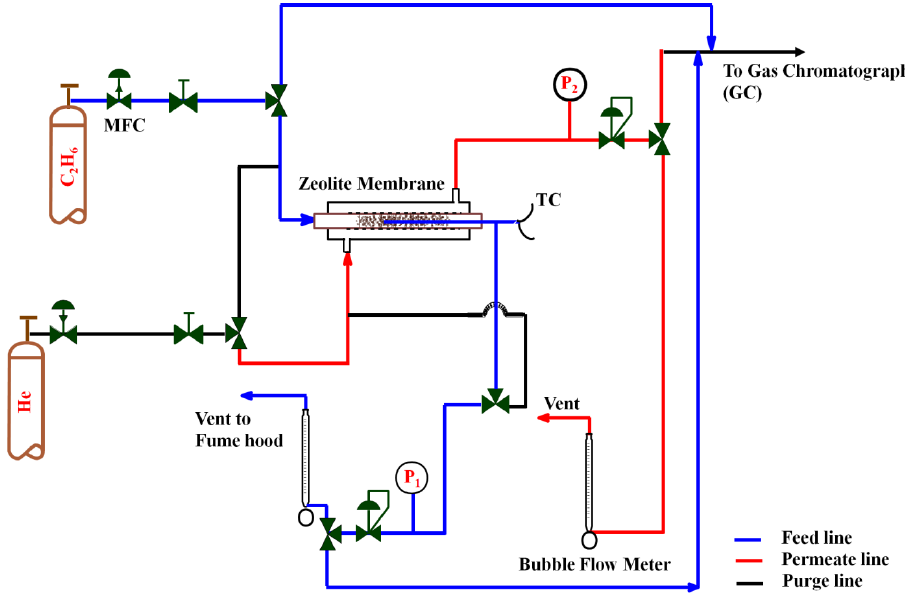
Figure 7. Schematic of the set-up for the gas permeation measurement.